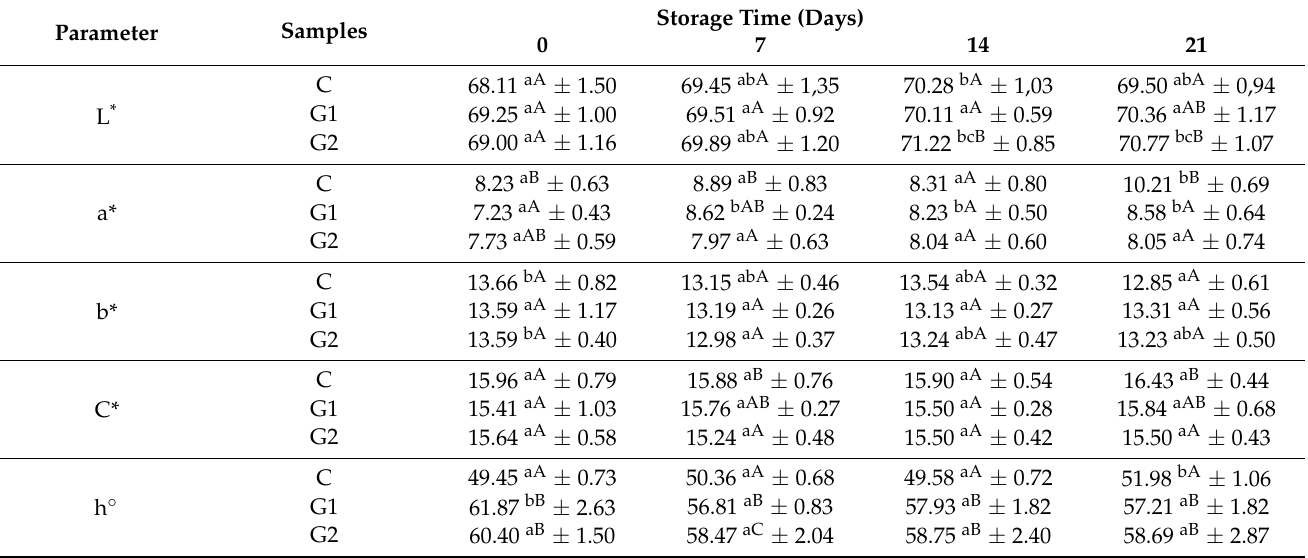
Table 3. The effect of ginger rhizome and storage time on the colour parameters of pork meatloaf.